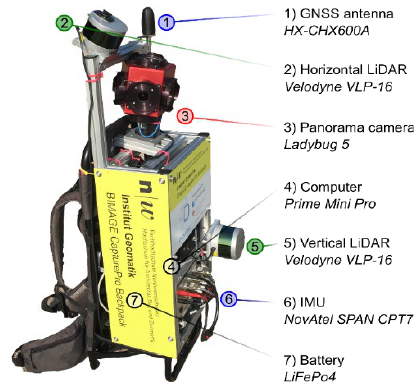
Figure 3. BIMAGE Backpack (Blaser et al.,